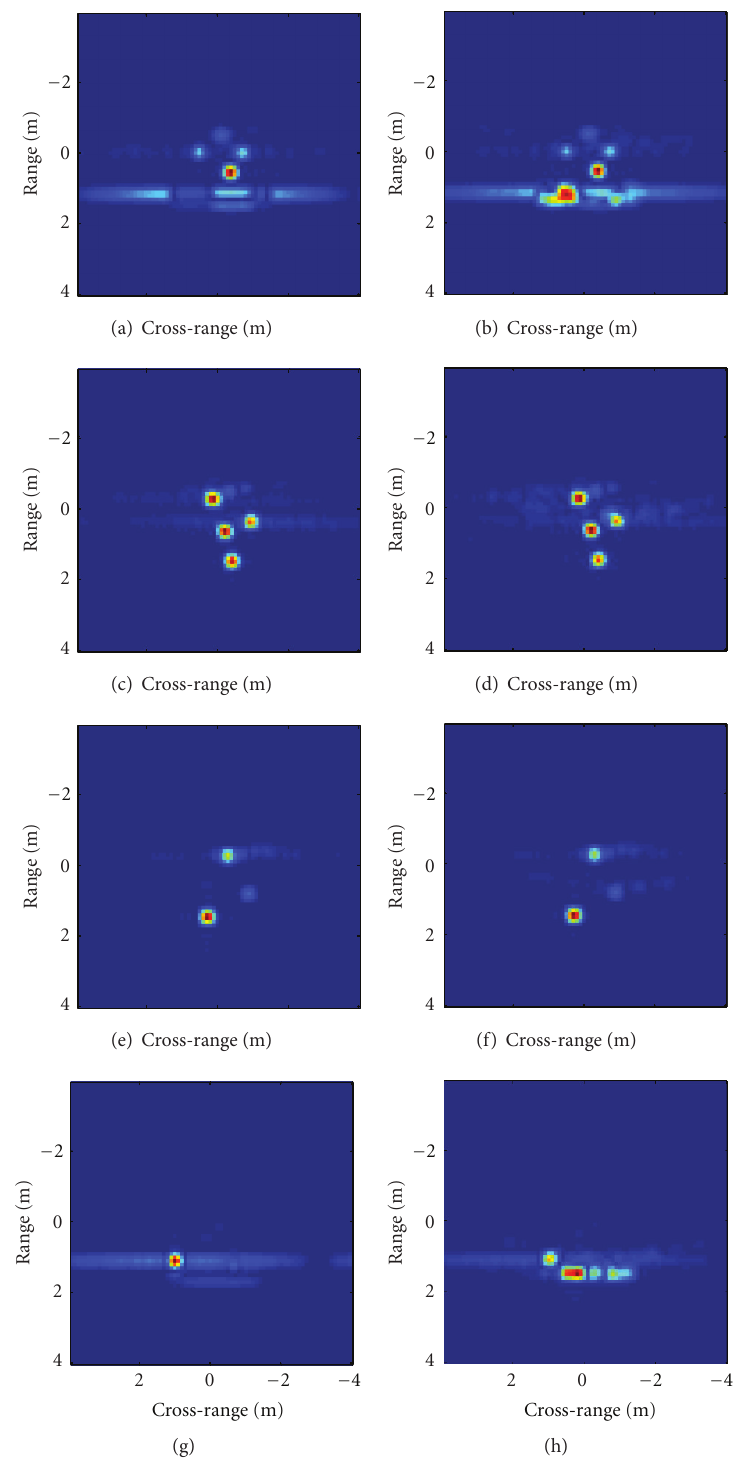
F 3: e 2D HH-polarization SAR images of the SLICY-like target in free space and above a Gaussian rough surface, in which the and ), the resolution is �.�m, and the ma�imum re�ection number is 3. (a) e SAR image incident direction is ( . (b) e SAR image of target above a Gaussian rough surface at the azimuth of of target in free space at the azimuth of ∘ ∘ ∘ ∘ ∘ . (d) e SAR image of target above a Gaussian rough surface at the azimuth of SAR image of target in free space at the azimuth of 𝜙𝜙 𝜃 𝜙𝜙 ,3𝜙 ,6𝜙 ,9𝜙 ] 𝜃𝜃 𝜃 𝜃𝜃 ∘ . (e) e SAR image of target in free space at the azimuth of . (f) e SAR image of target above a Gaussian rough surface at 𝜙𝜙𝜃𝜙 ∘ . (g) e SAR image of target in free space at the azimuth of . (h) e SAR image of target above a Gaussian the azimuth of 𝜙𝜙𝜃 3 𝜙 ∘ ∘ rough surface at the azimuth of 𝜙𝜙 𝜃 6𝜙 𝜙𝜙 𝜃 3𝜙 ∘ ∘ 𝜙𝜙𝜃 9 𝜙 𝜙𝜙 𝜃 6𝜙 ∘ 𝜙𝜙 𝜃 9𝜙